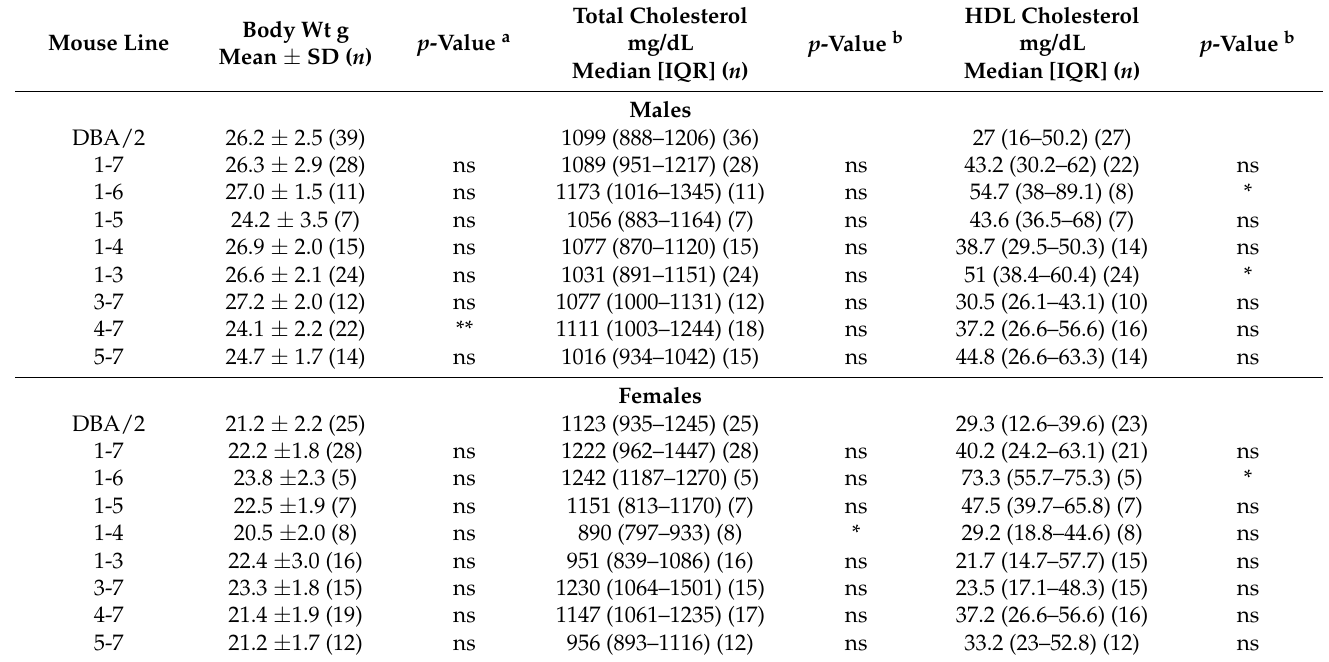
Table 1. Body weights, total plasma, and HDL cholesterol levels in DBA/2 and congenic